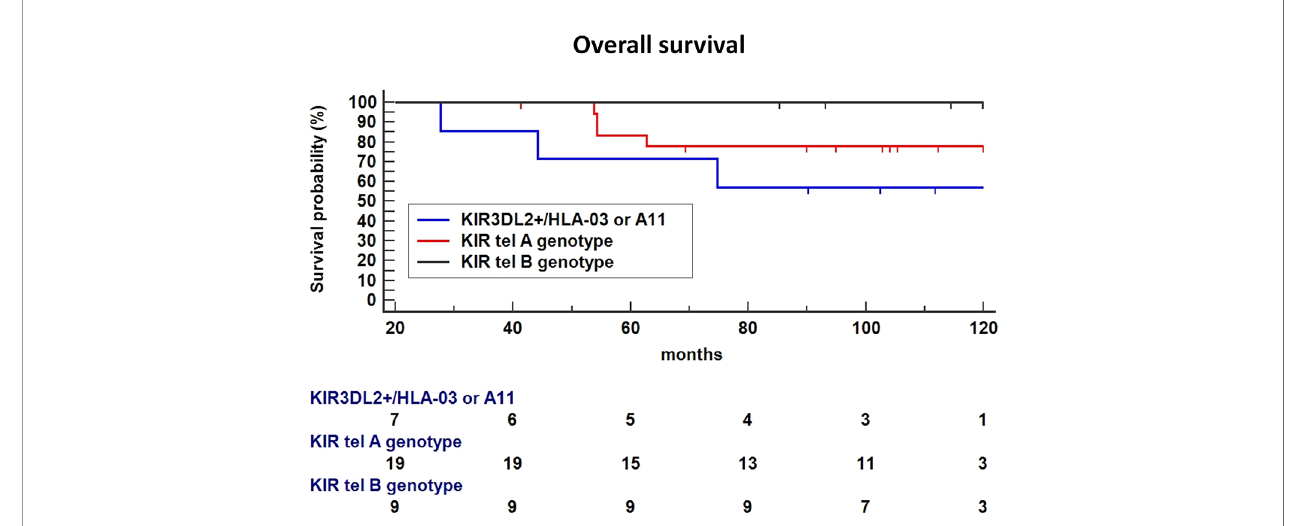
FIGURE 7 | In Breast Cancer (BC) patients treated with Neoadjuvant Chemotherapy (NC), the haplotype including the functional tel B genotype and the KIR3DL2 +/ligand was signi fi cantly associated with a poor Overall Survival (OS) compared to tel B haplotype without the 3DL2+/ligand as the reference (P = 0.0328), a trend toward a lower-survival was found using Tel A without the 3DL2+/ligand combination as the reference (HR: 2.66, 95%CI 0.47-14.8,